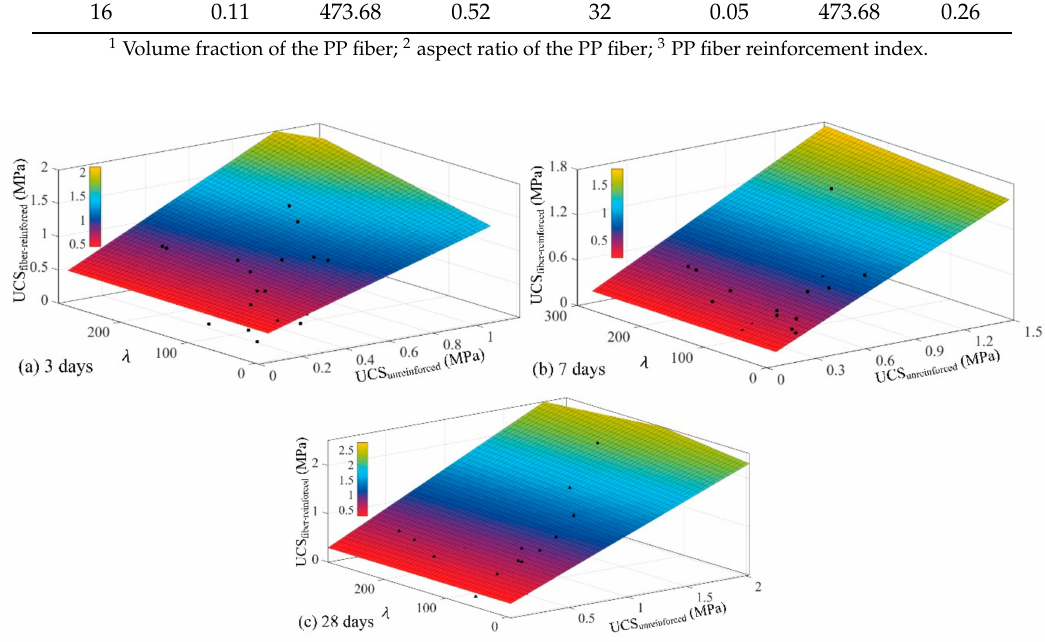
Figure 11. The fitting formula of UCS fiber-reinforced based on composite mechanics with di ff erent curing times: ( a ) 3 days curing time; ( b ) 7 days curing time; ( c ) 28 days curing time. Table 6. The results of the estimated UCS fiber-reinforced based on composite mechanics. Curing